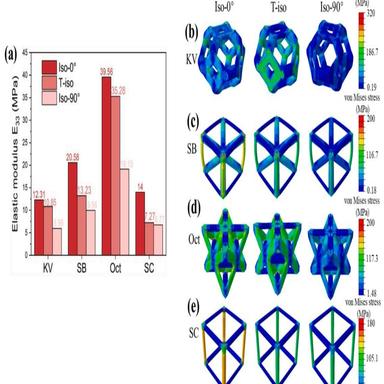
Elastic behavior of 3d printed lattices indifferent material models. (a) Elastic modulus, (b-d) Deformation states of KV, SB, Oct, and SC lattices, respectively.